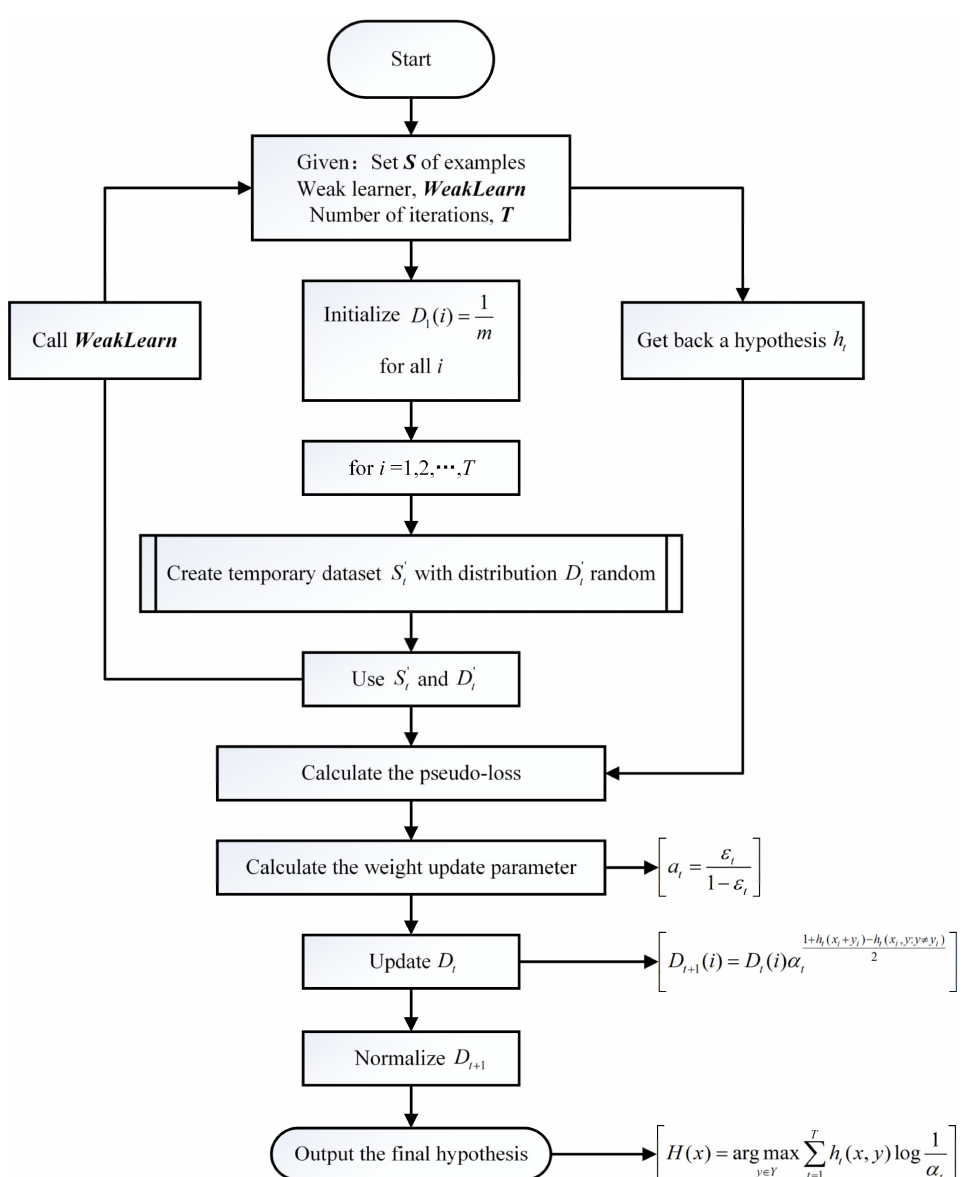
Figure 7. Flow chart of RUS boost basic